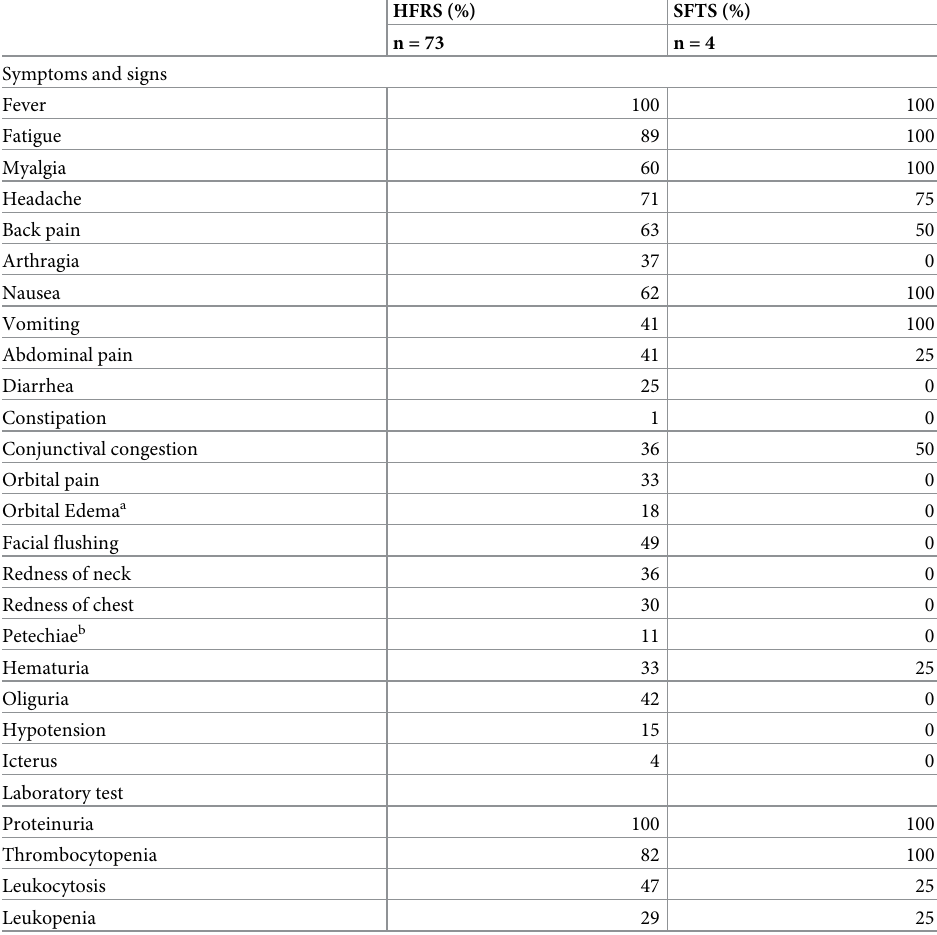
Table 1. Comparison of clinical symptoms and laboratory test of HFRS and